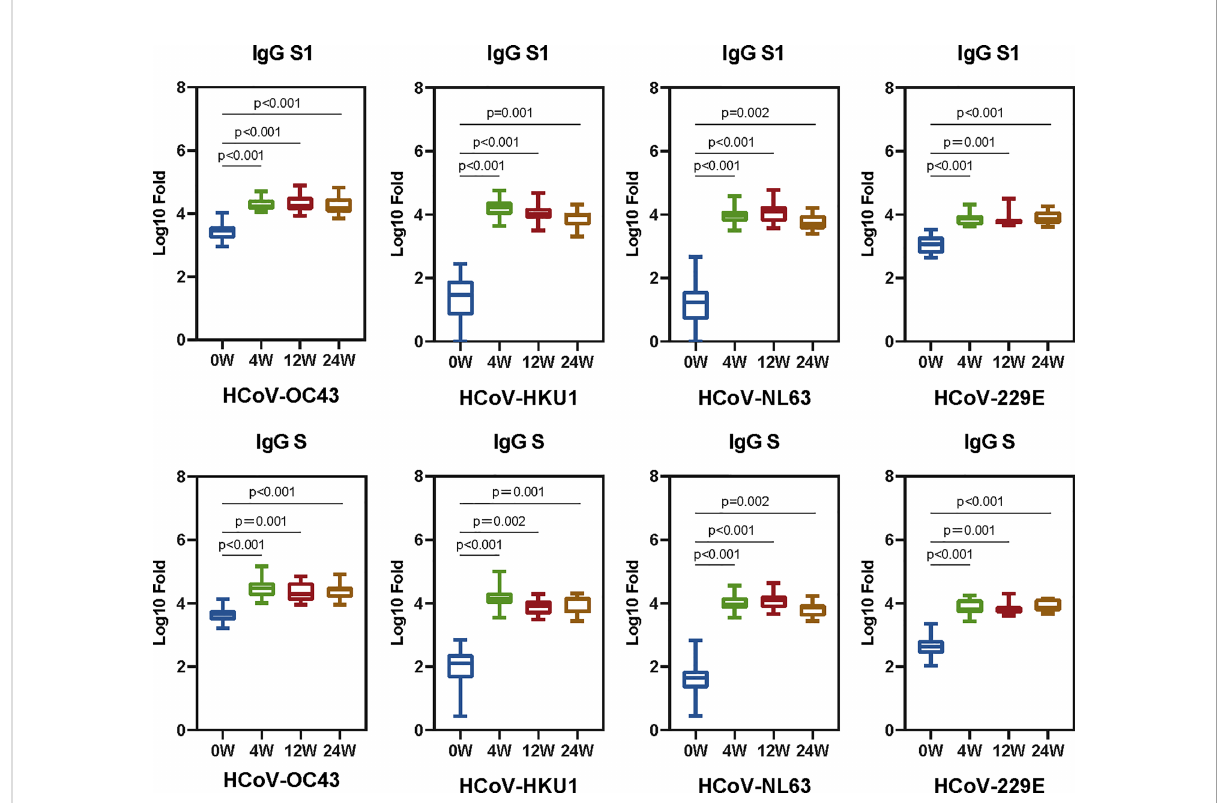
FIGURE 2 The SARS-CoV-2 vaccine boosts antibodies that are reactive to seasonal HCoVs. We quanti fi ed the serum IgG antibodies to the S and S1 proteins against HCoVs (HCoV-OC43, HCoV-HKU1, HCoV-NL63, and HCoV-229E). The IgG geometric mean titers (GMT) against seasonal HCoVs spike and S1 are shown in the boxplot. Two-tailed, nonparametric Dunn ’ s Kruskal – Wallis test was used for multiple comparisons. The middle bars indicate the GMT values, the box indicates interquartile range, and the lines indicate minimum and maximum. Statistically signi fi cant values are marked in the fi